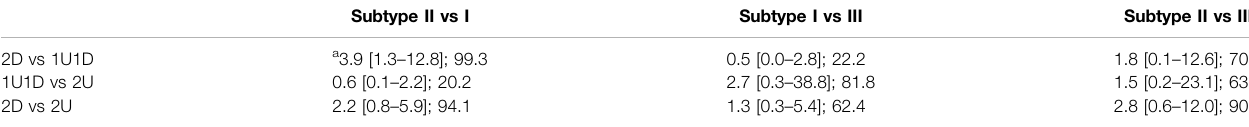
TABLE 3 | Risk of having a subtype compared to another depending on the position of the